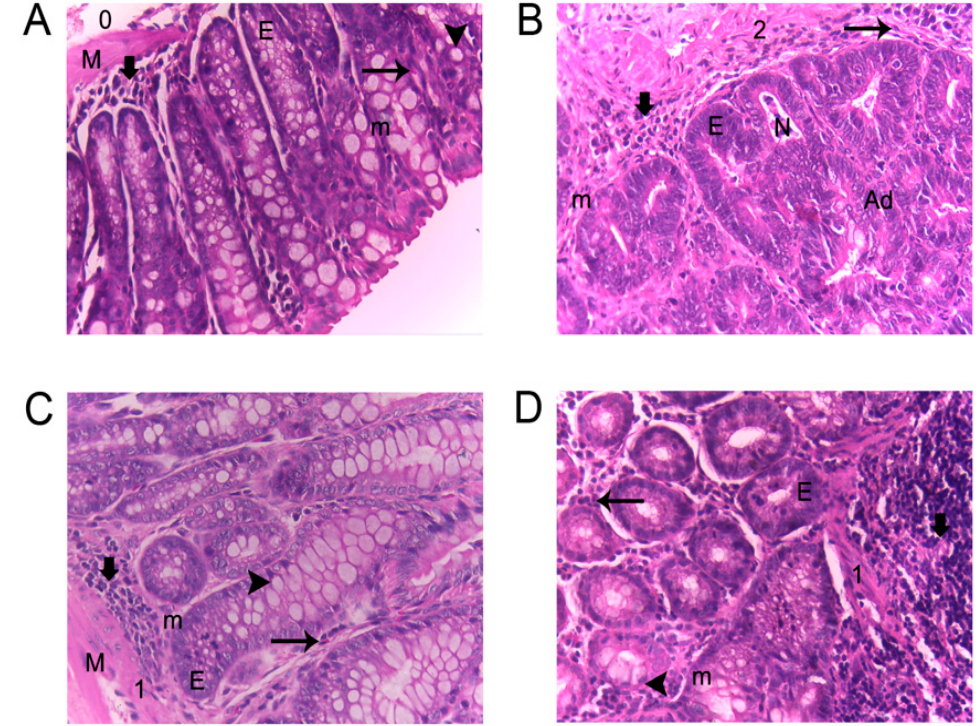
Figure 2. Histopathological features of colonic mucosa of AOM + DSS-treated mice. H&E staining: ( A ) Normal group, ( B ) AOM + DSS group, ( C ) AVA + AOM + DSS group, ( D ) SO + AOM + DSS group. n = 8–10 mice per group. ( ) Lymphocyte infiltration; ( ) eosinophils; ( ) goblet cells; (E) epithelial ridges; (M) defined muscularis; (m) mitosis; (N) necrosis; (0,1,2) inflammation grade; and (Ad) adenocarcinoma.